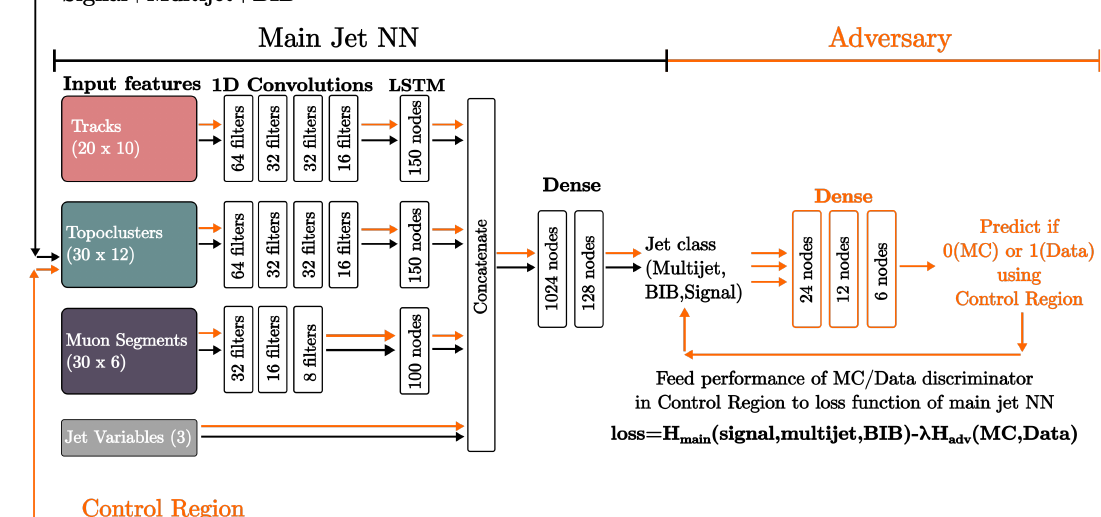
Figure 4. A simplified diagram of how the adversarial network is structured. The principal network which discriminates between signal, SM multijets and BIB is shown with the inputs moving through the network as black arrows. Dense layers refer to fully-connected layers, while LSTM refers to Long-Short Term Memory layers described in the text. The adversary which classifies jets as being MC simulation or data is shown with the inputs moving through the network as orange arrows. The input variables are labelled n × m where n is the maximum of the number of tracks, topoclusters or muon segments per jet and m is the number of distinct variables per input